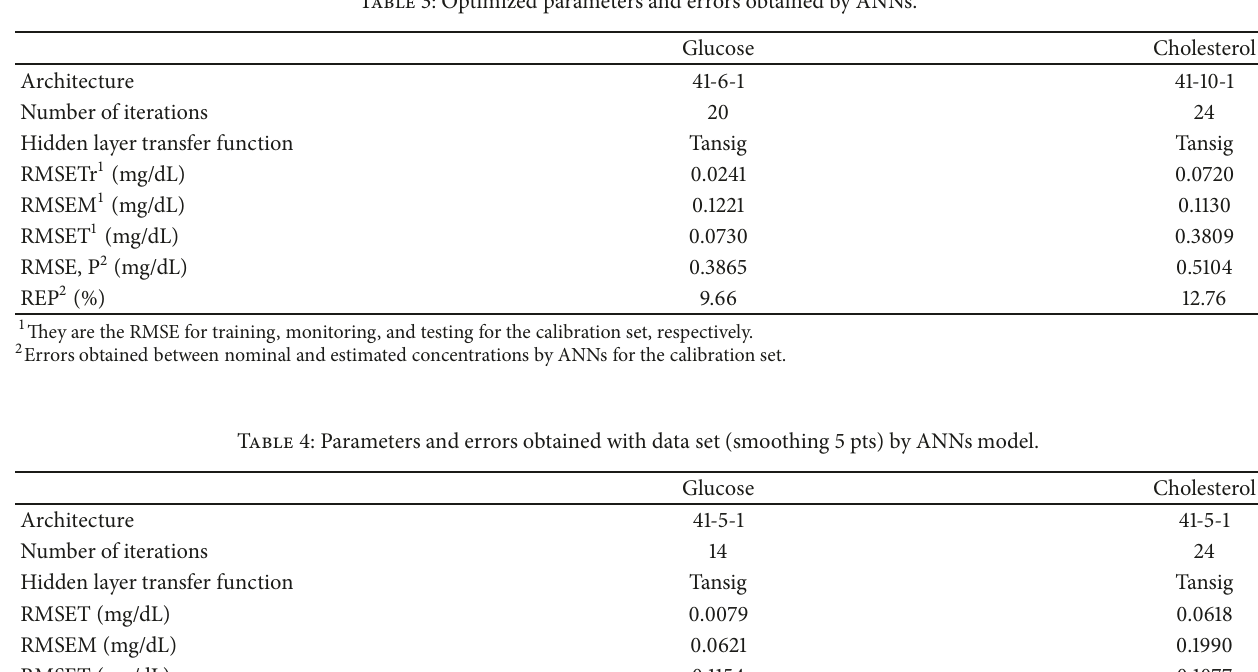
Table 3: Optimized parameters and errors obtained by ANNs.